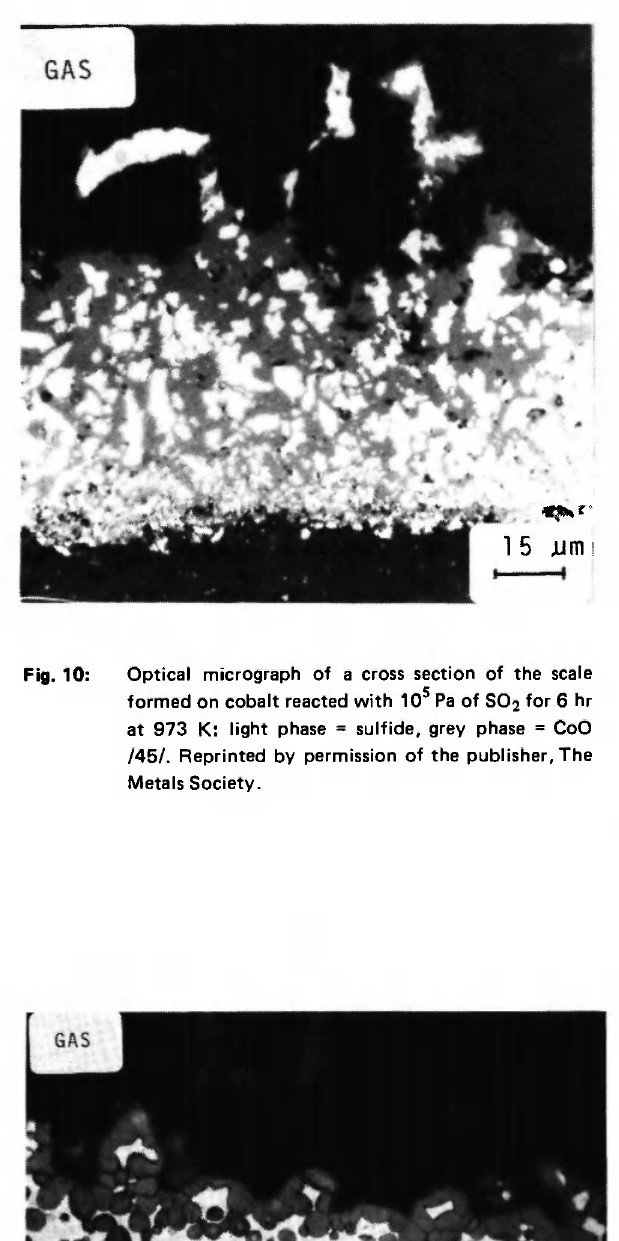
Fig. 12: SEM fractography of the scale formed on cobalt reacted with 10 s Pa of S0 2 for 6 hr at 1273 Κ /45/. Reprinted by permission of the publisher, The Metals